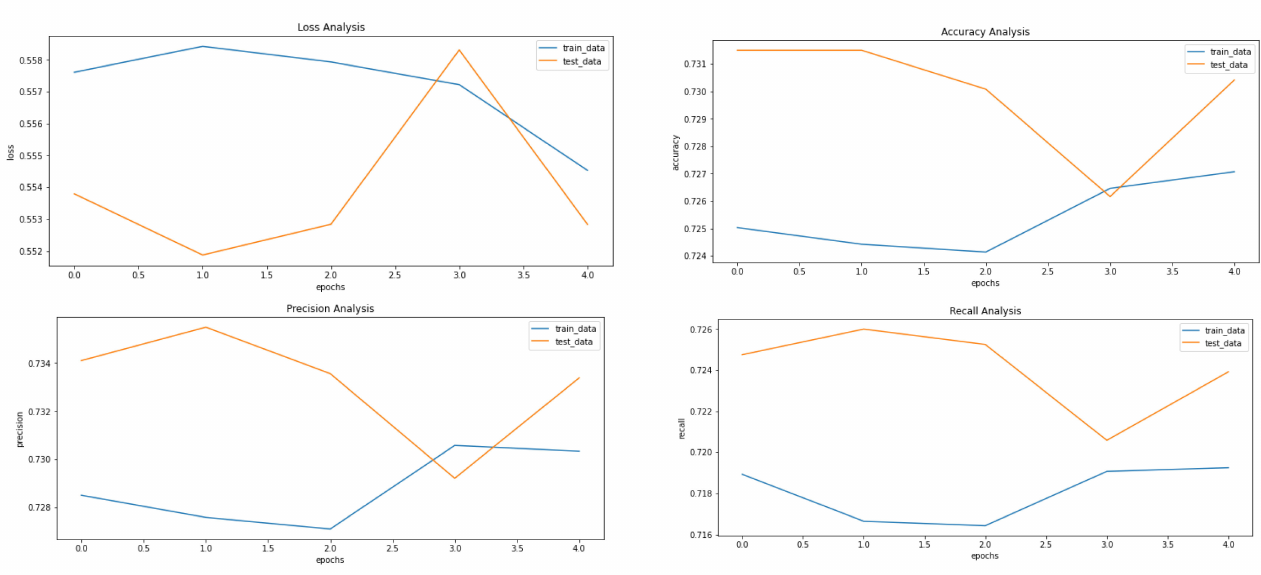
Figure 8. Results achieved after classification using CNN after applying and reconstructing input images using Convolutional VAE. It shows loss, accuracy, precision and recall from left to